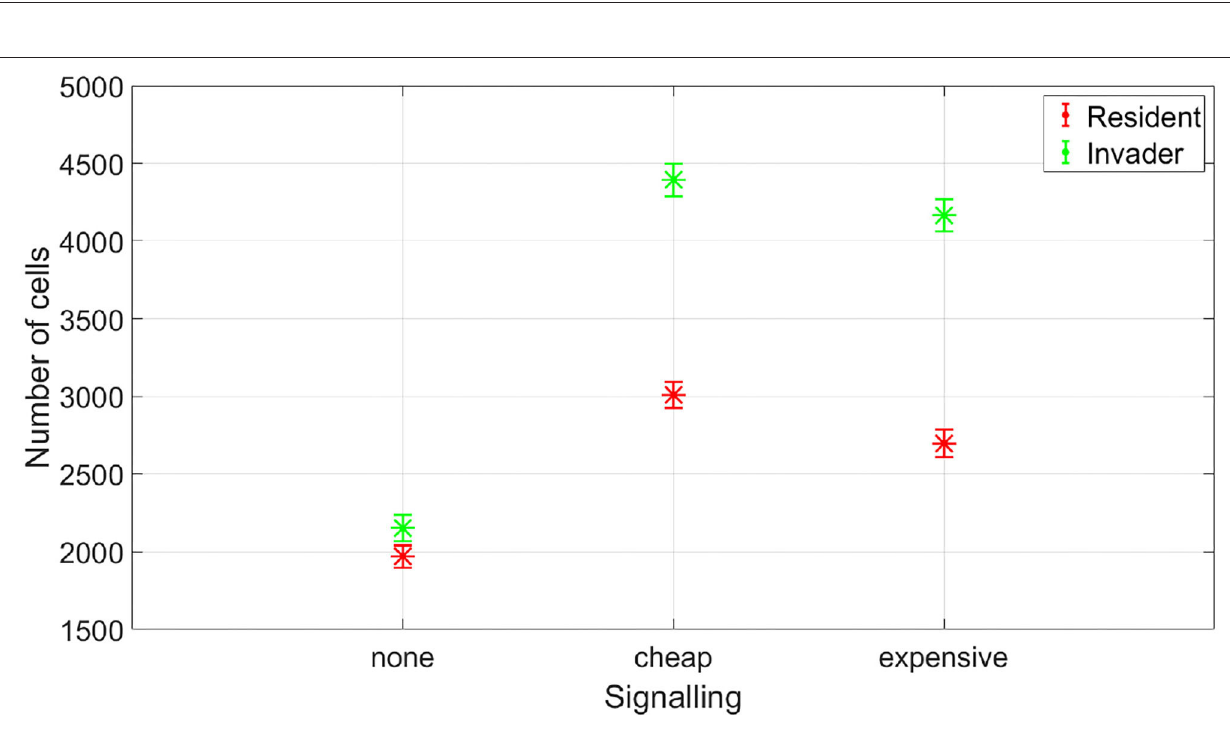
Frontiers in Microbiology |